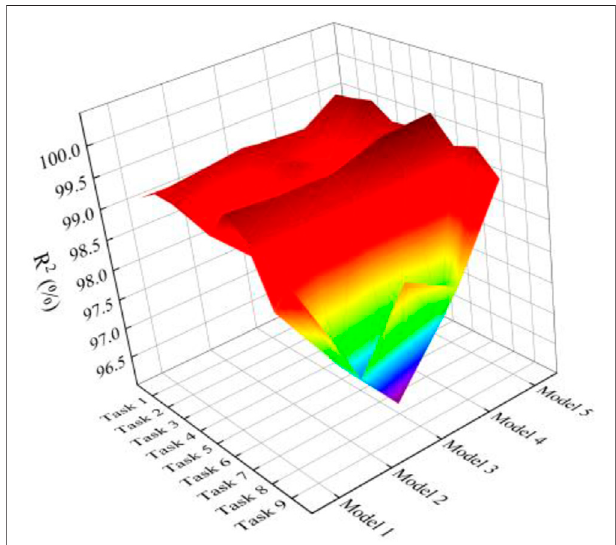
FIGURE 7 | R 2 of models in different prediction tasks.